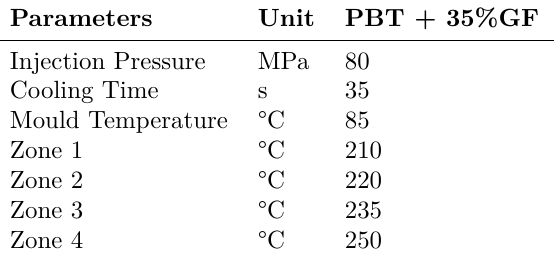
Table 1. Injection Molding Parameters.